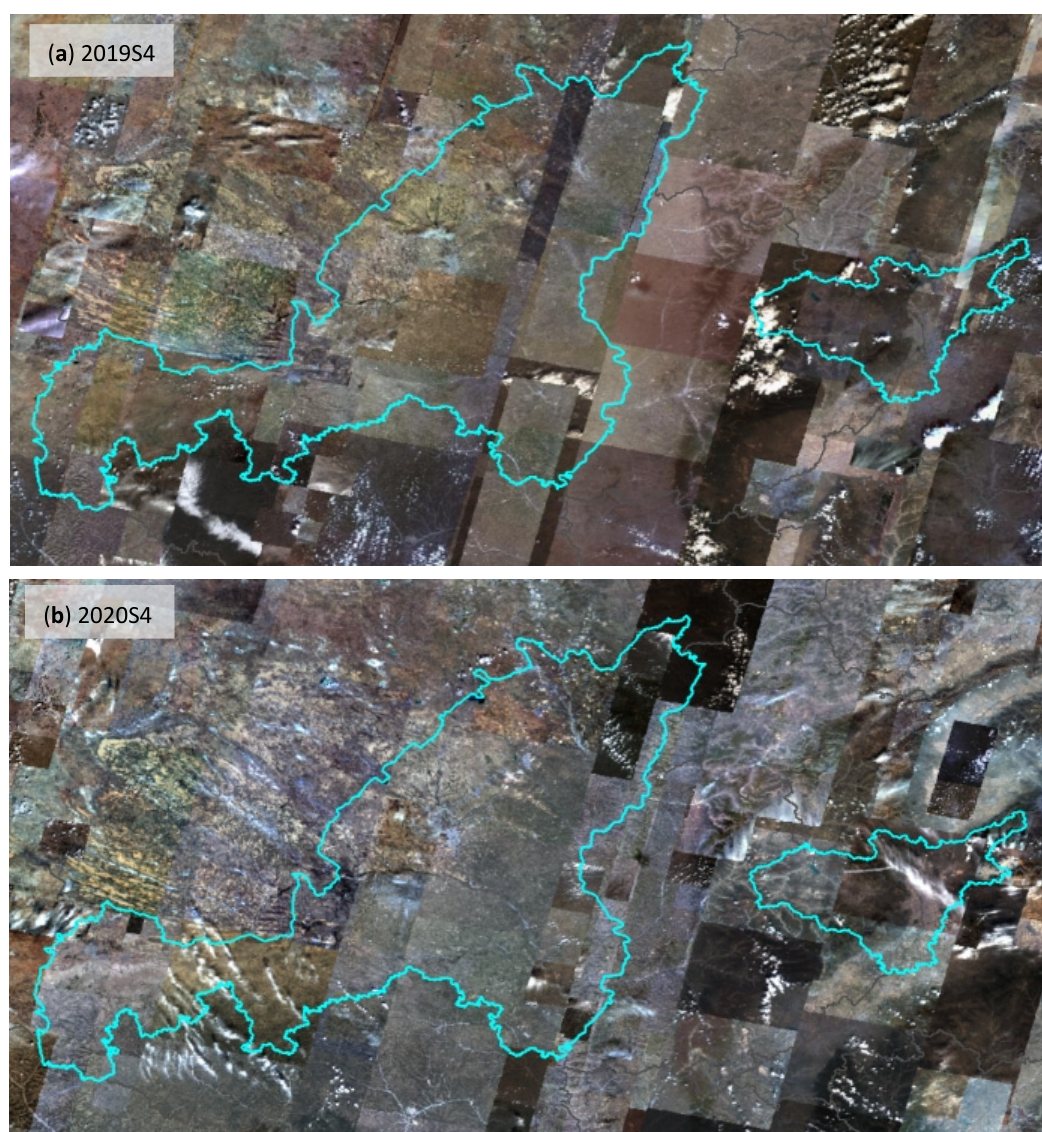
Figure 7. Bi-temporal multi-sensor mosaic images of the experimental area: ( a ) Images from the fourth quarter of 2019; ( b ) Images from the fourth quarter of 2020.